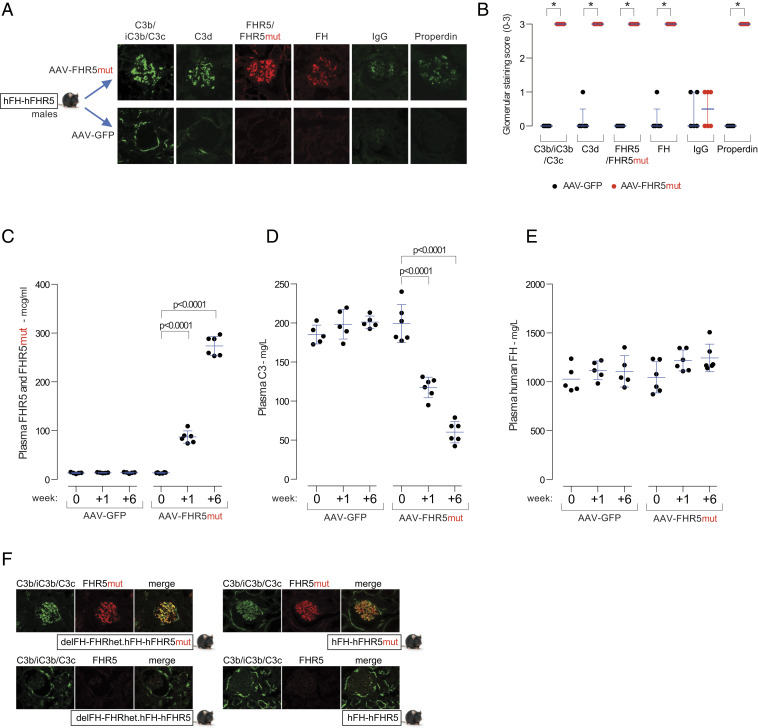
FHR5mut triggers glomerular C3 deposition in hFH-FHR5 mice. (A) Representative glomerular images and (B) staining scores for C3b/iC3b/C3c, C3d, FHR5/FHR5mut, FH, IgG, and properdin in male hFH-FHR5 mice treated with either AAV-GFP (n = 5, black dots) or AAV-FHR5mut (n = 6, red dots). Bars denote the median, and whiskers denote the interquartile range. *P = 0.0022; values are derived from Mann–Whitney U test. Plasma FHR5/FHR5mut (C), C3 (D), and FH (E) levels after administration of either AAV-FHR5mut or AAV-GFP to hFH-FHR5 male mice. Bars denote the mean, and whiskers denote the SD. P values are derived from two-way ANOVA with Bonferroni multiple comparisons test. (F) Representative glomerular images of C3b/iC3b/C3c, C3d, and FHR5mut in male hFH-FHR5mut mice expressing one copy of the transgene on the background of either heterozygous (delFH-FHRhet.hFH-FHR5mut) or homozygous (hFH-FHR5mut) deficiency of the mouse FH-FHR locus. Controls are male delFH-FHRhet.hFH-FHR5 and hFH-FHR5 animals.